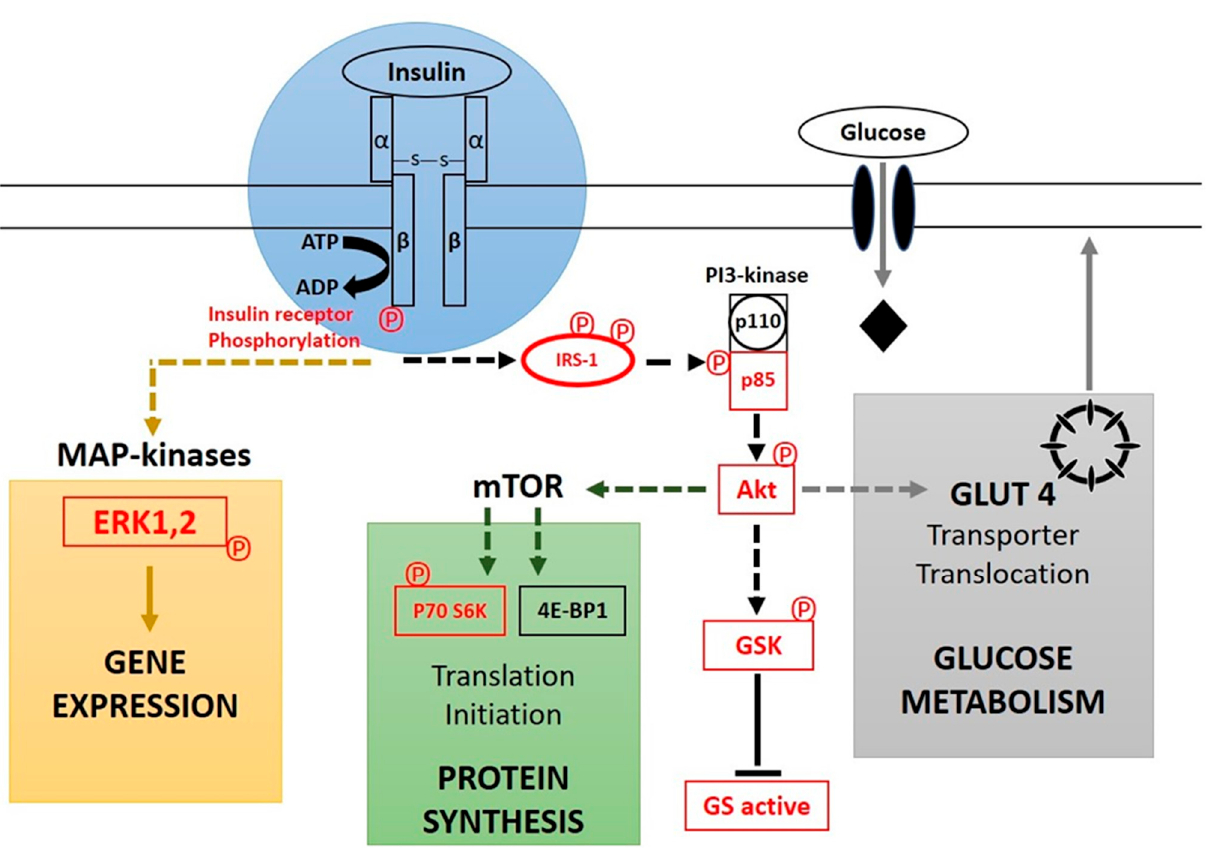
Figure 1. Insulin signal transduction. The insulin receptor (IR) is in blue, the MAP-kinase pathway to gene expression is highlighted in light-brown, and dark-green lines point to the proximal common pathway to protein synthesis (highlighted in green) and glucose metabolism (highlighted in gray). Phosphorylated proteins, IR (insulin receptor), extracellular signal-regulated kinases 1 and 2 (ERK1,2), insulin receptor substrate 1 (IRS-1), the p85 subunit of phosphatidylinositol 3-kinase (PI 3-kinase), Akt protein kinase (Akt), S6 protein kinase (p70 S6K), glycogen synthase kinase (GSK), and glycogen synthase (GS), are in red. P (phosphate group), (–S–S–) disulfide bond, mTOR (mam- malian target of rapamycin), ATP (adenosine triphosphate), ADP (adinosine diphosphate) and MAP (mitogen-activated protein).